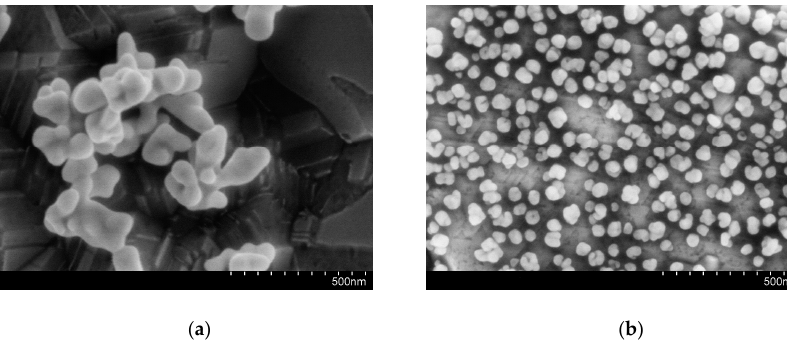
Figure 7. The morphology of the AuNPs–BDD electrode with anodic ( a ) and cathodic ( b ) pretreatment after